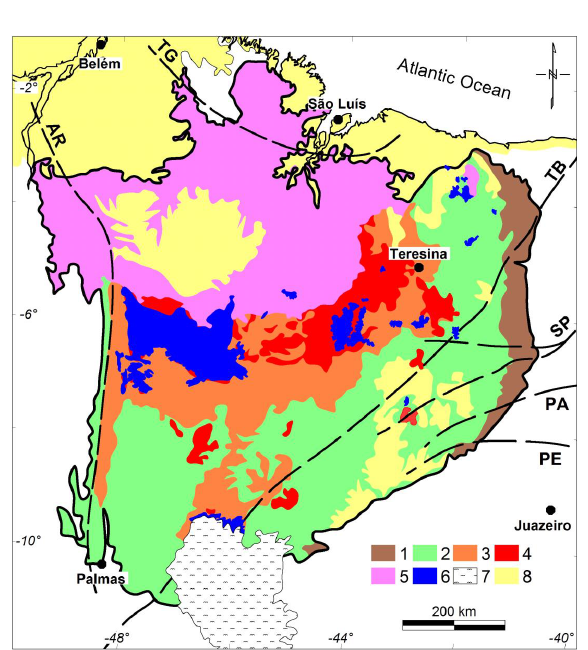
Figure 3. Simplified geological map of the Parnaíba basin (adapted from CPRM, 2015). Stratigraphic units: 1 – Silurian; 2 – Devonian– Carboniferous; 3 – Permian–Triassic; 4 – Jurassic; 5 –